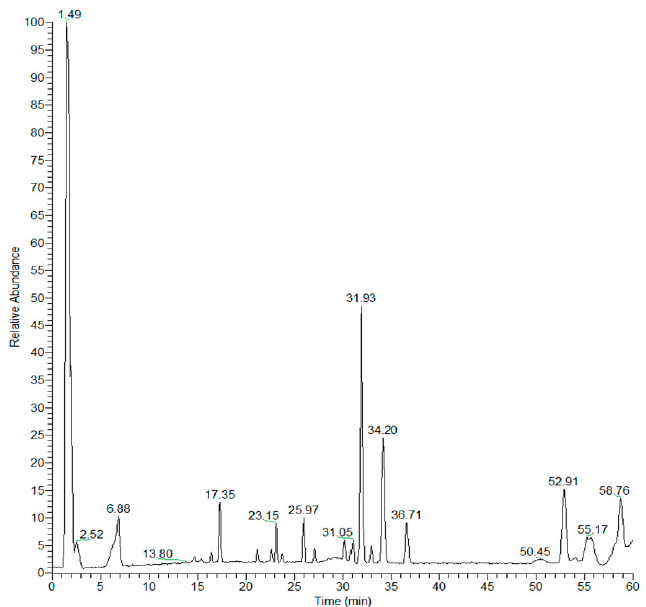
Figure 1. LC-ESI/HRMS chromatogram (base peak intensity, negative ion mode) of black garlic methanol extract (BGE).